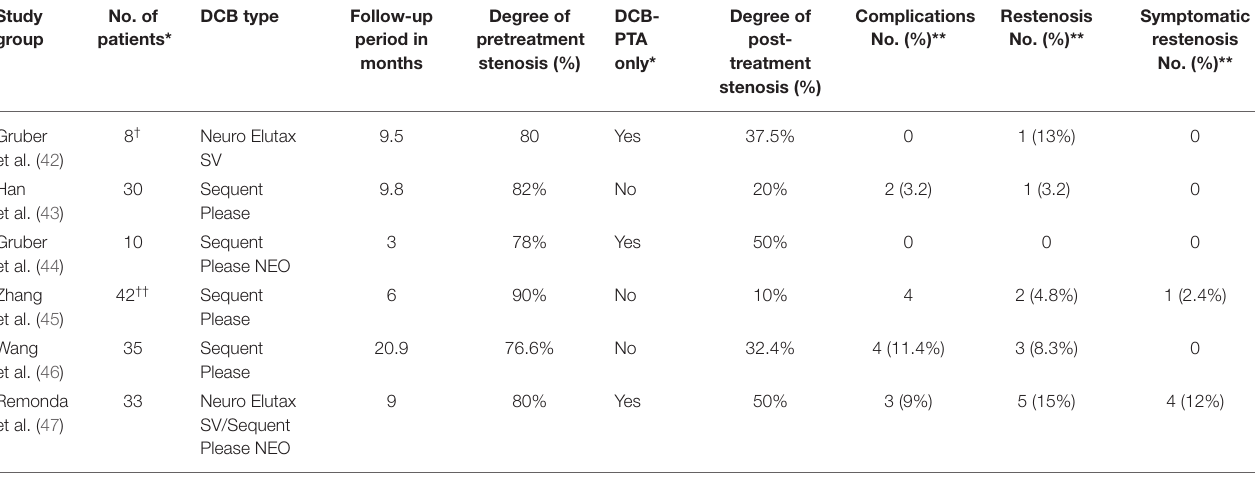
TABLE 1 | An overview of existing drug-coated balloon percutaneous transluminal angioplasty (DCB-PTA) studies in patients with symptomatic high-grade intracranial stenosis. Study No. of DCB group patients*